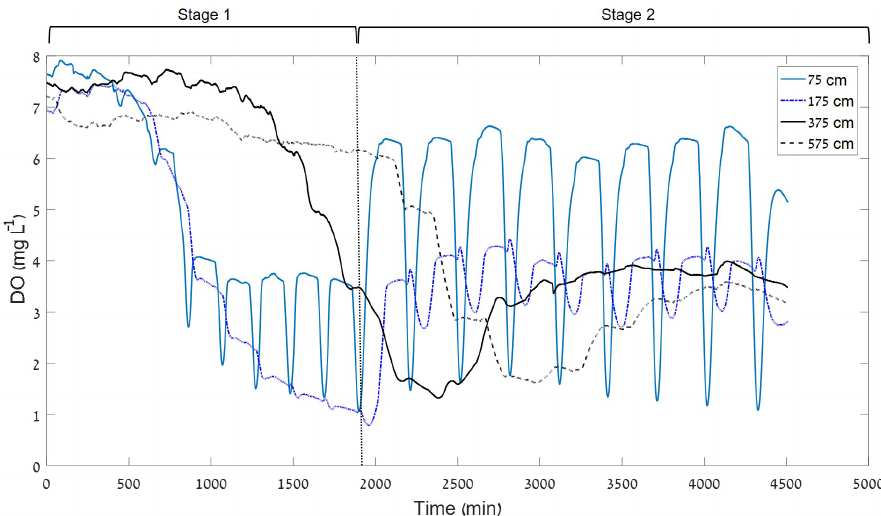
Figure 3. DO concentrations at depths of 75, 175, 275 and 575cm in response to the increase in DP (between SW150 and SW240). Note the convergence of the deep sensors to < 2mgL − 1 during the short DP versus convergence to > 3mgL − 1 in response to the longer